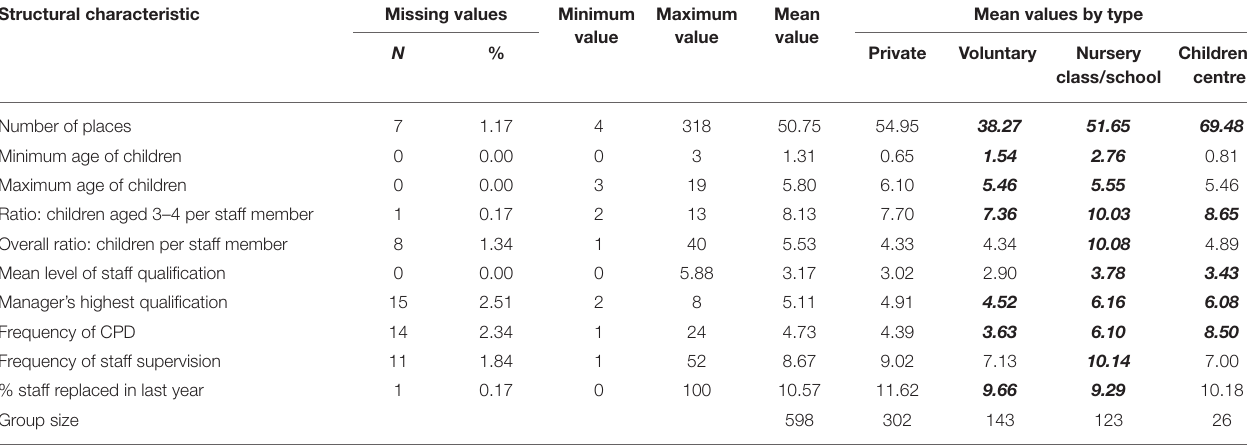
TABLE 1 | Summary of continuous structural characteristics.